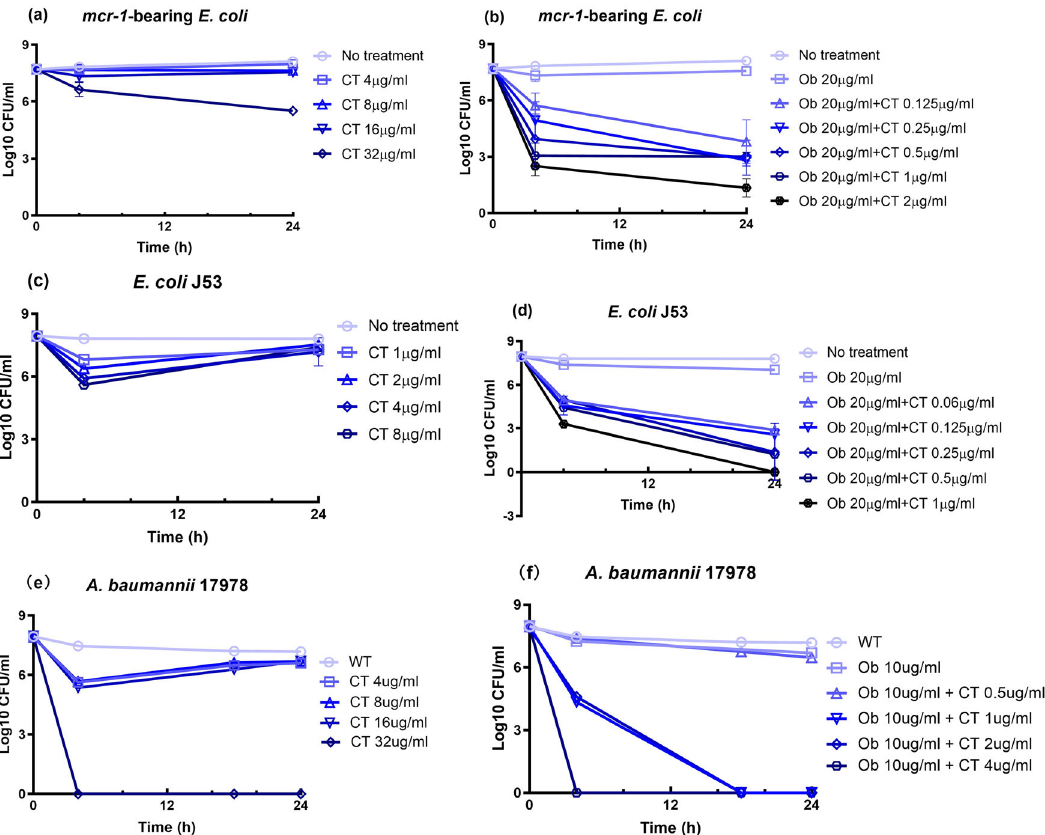
Fig. 4 Assessment of the synergistic antimicrobial effect of Ob and colistin on starvation-induced persisters of colistin-resistant and colistin- susceptible ESKAPE bacterial pathogens. All strains had been starved for 24 h prior to treatment with various concentrations of colistin alone, Ob alone or a combination of both. a Population size of mcr-1 -bearing E. coli treated with different concentrations of colistin; b population size of mcr-1 -bearing E. coli treated with different concentrations of colistin and 20 µ g/ml Ob; c population size of colistin-susceptible E. coli J53 treated with different concentrations of colistin; d population size of colistin-susceptible E. coli J53 treated with different concentrations of colistin and 20 µ g/ml Ob; e population size of colistin- susceptible A. baumannii 17978 treated with different concentrations of colistin; f population size of colistin-susceptible A. baumannii 17978 treated with different concentrations of colistin and 10 µ g/ml Ob. CT, colistin. Data are mean ± SEM for n = 3 biologically independent